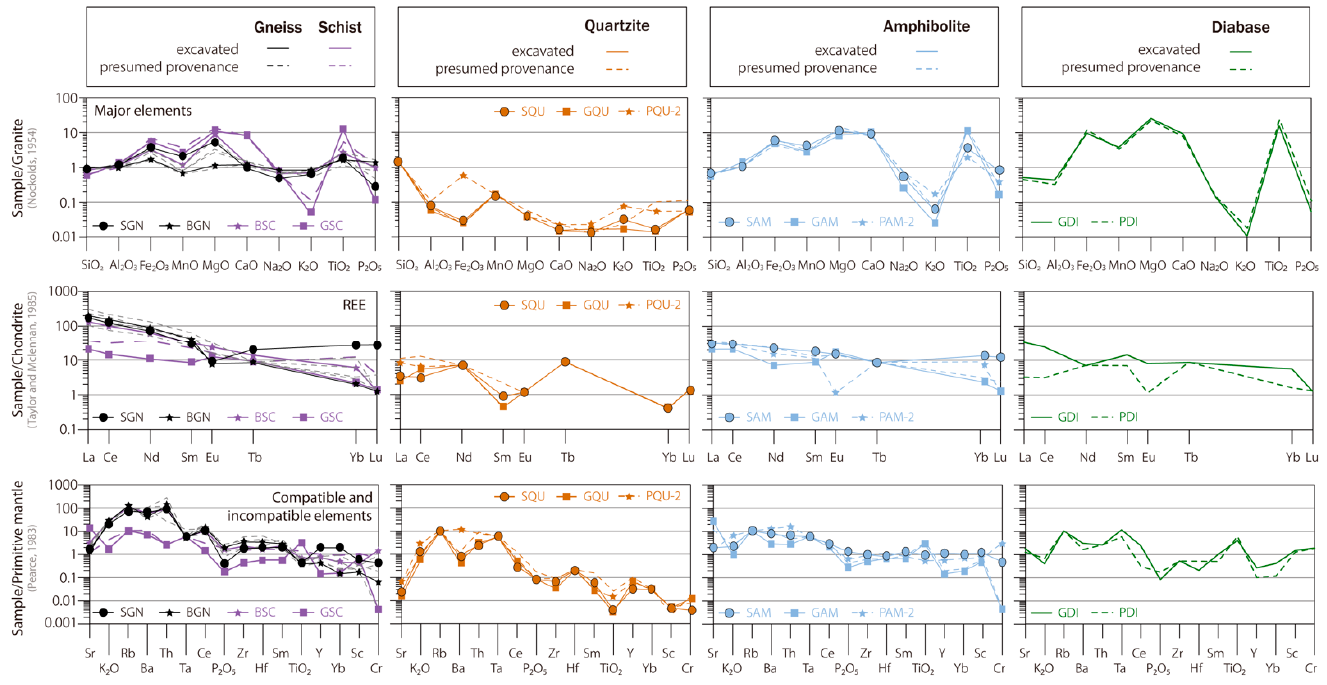
Figure 7. Normalized diagram showing the behavior patterns for composing elements of rock samples presented as in those of Table 1.